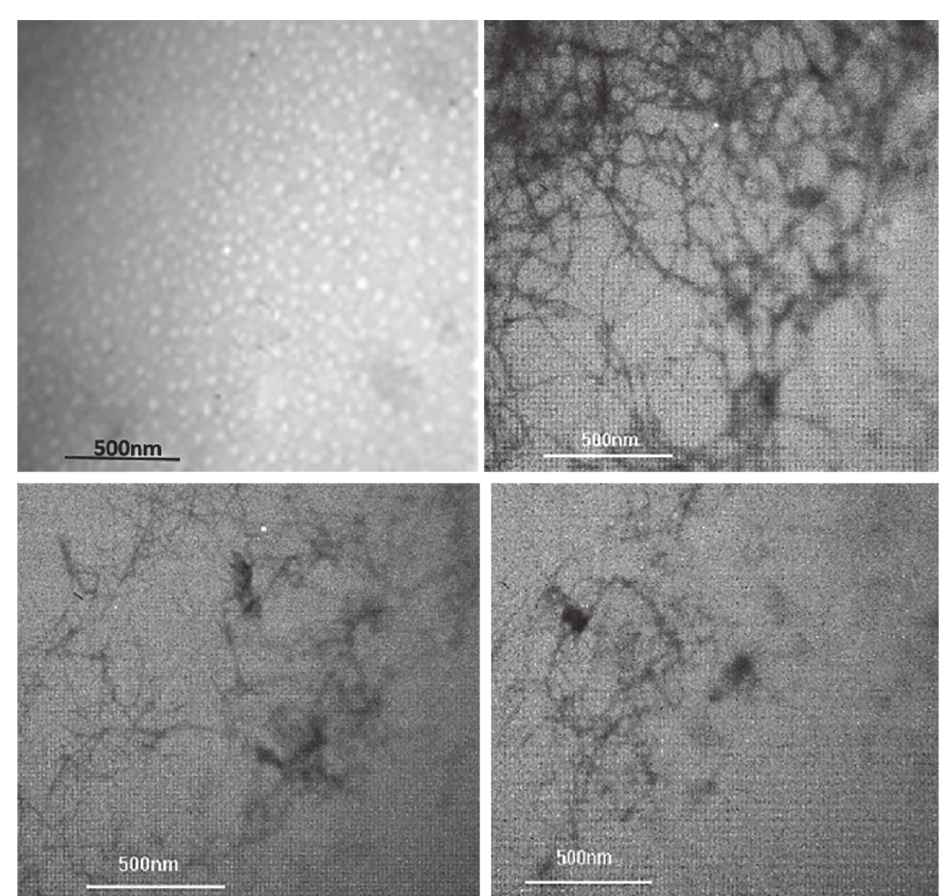
FIGURE 6 - Electron microscope analysis of Aβ42 fibrillation with and without alpha-terpineol. TEM images of Aβ42 fibrillation after immediate incubation (a) and 4 days (b) in the absence of alpha-terpineol. The second row indicates the four-day-old Aβ42 fibrils incubated with alpha-terpineol 100 µM for 1 week (c) and 3 weeks